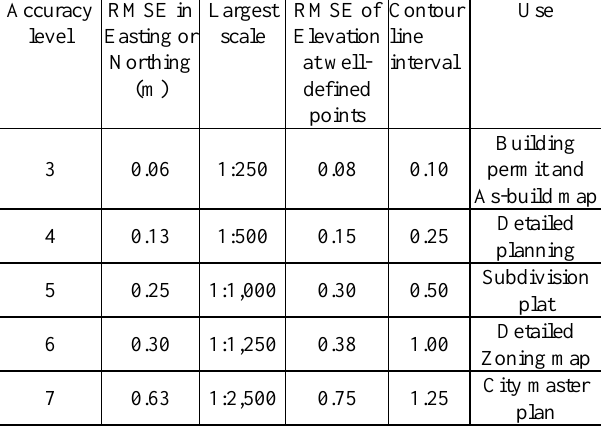
Table 1: accuracies of mapping products from the